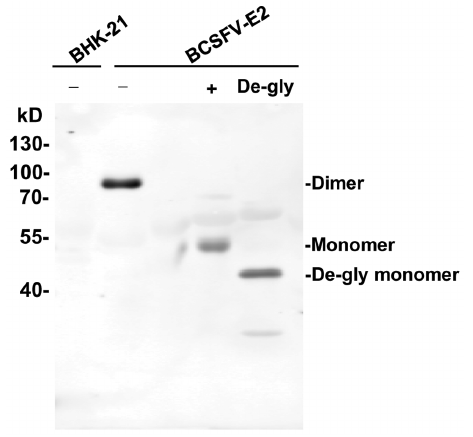
Figure 4. Western blot analysis of mE2 in culture supernatants. BHK-21 cells and BCSFV-E2 cells culture supernatants were separated in the absence ( + ) or presence ( + ) of b -mercaptoethanol or treated with peptide: N -glycosidase F (PNGase F) followed by Western blot analysis with 12C4 monoclonal antibody.